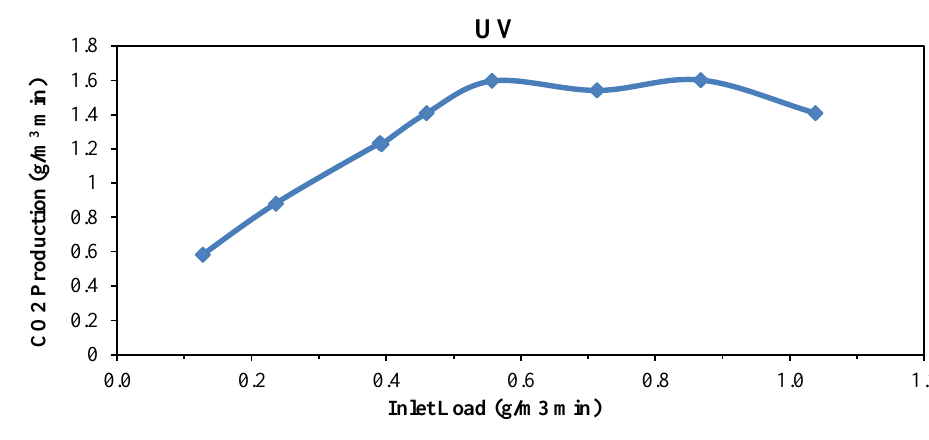
Figure 5. CO production against the ethlylbenzene inlet load in photocatalytic 2